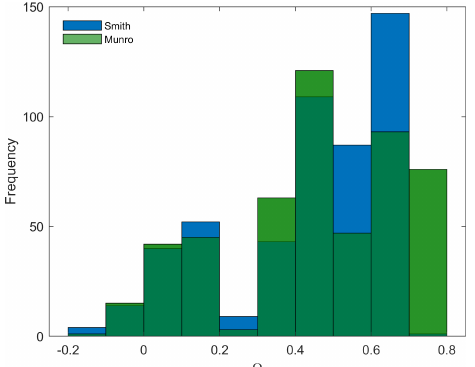
Figure 10. Anisotropy ratio values for the two models of Smith (blue) and Munro (green) calculated for sub-grid z 0 values on Fridtjovbreen. The dark green colour corresponds to an overlap- ping of both models. A positive ratio towards 1 means that paral- lel winds (up- and down-glacier) are dominant over perpendicular winds